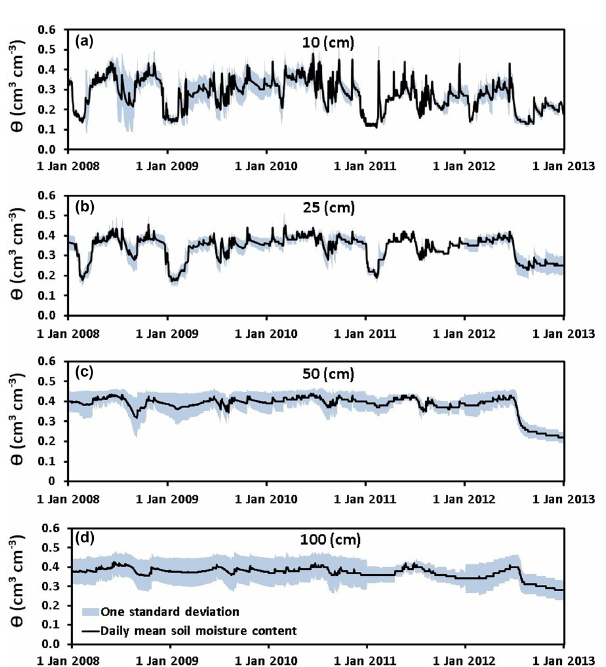
Figure 4. Temporal evolution of daily SWC ( θ ) at different soil depths. The black lines represent daily mean SWC ( θ ) calculated from TPs in four different locations at the study site and the blue areas indicate 1 standard deviation.